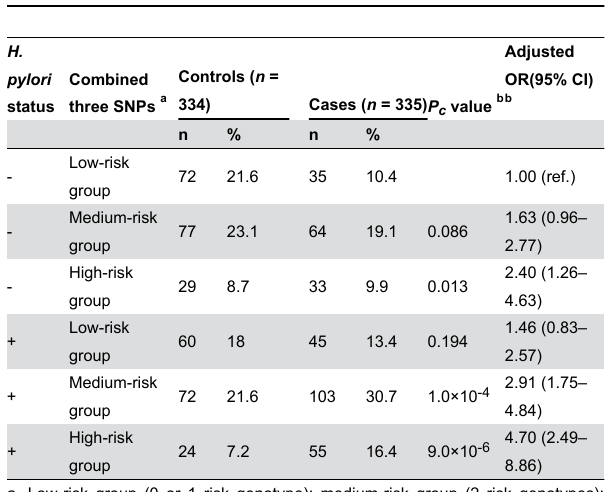
Table 4. Joint effect of H. pylori seropositivity and combined variants of three SNPs on risk of